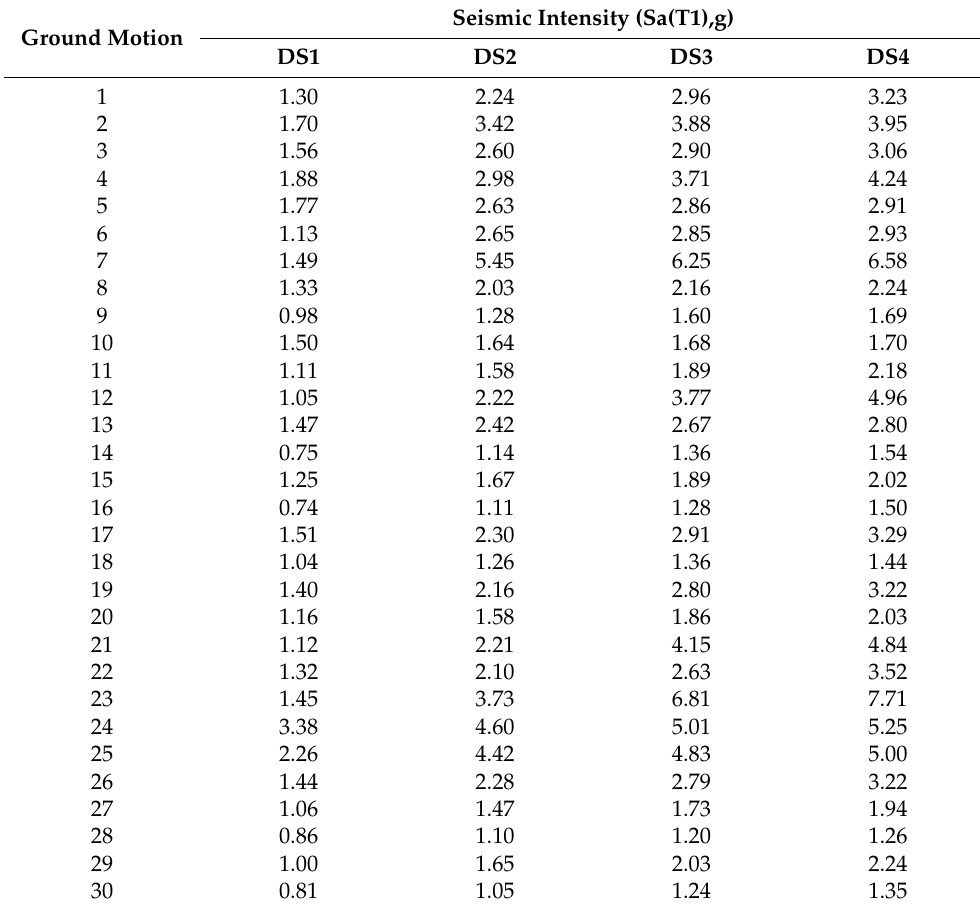
Table 2. Seismic intensities of the mainshocks to induce each damaged state. Ground